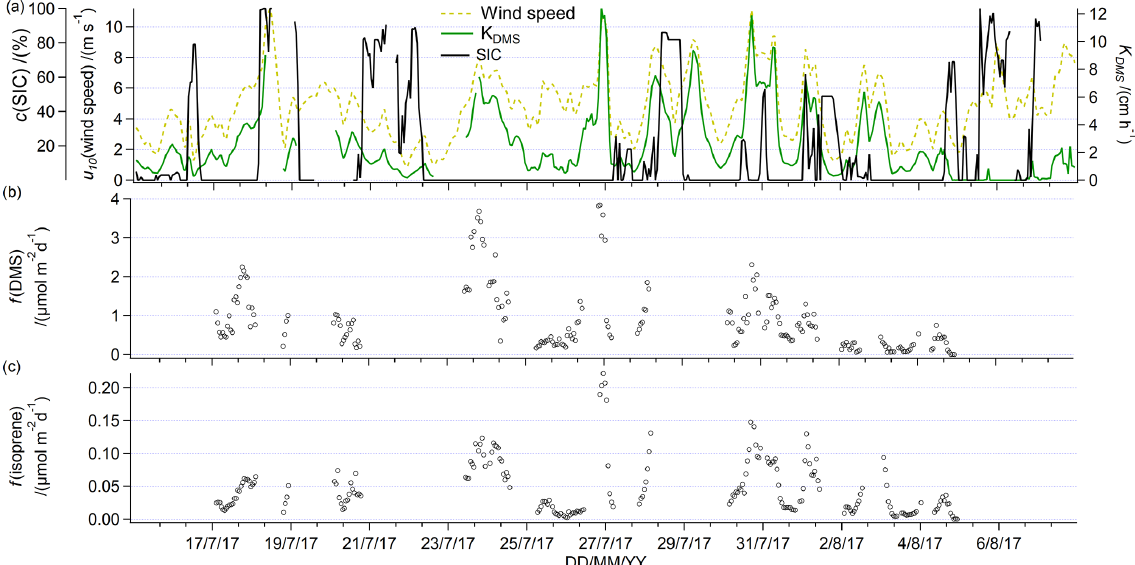
Figure 10. (a) Underway sea ice concentration, wind speed at 10m, and calculated air sea exchange velocity for DMS. Short gaps in the time series of the air sea exchange velocity of DMS are due to gaps in the recording of the underway sea surface temperature. Calculated underway fluxes of (b) DMS and (c)